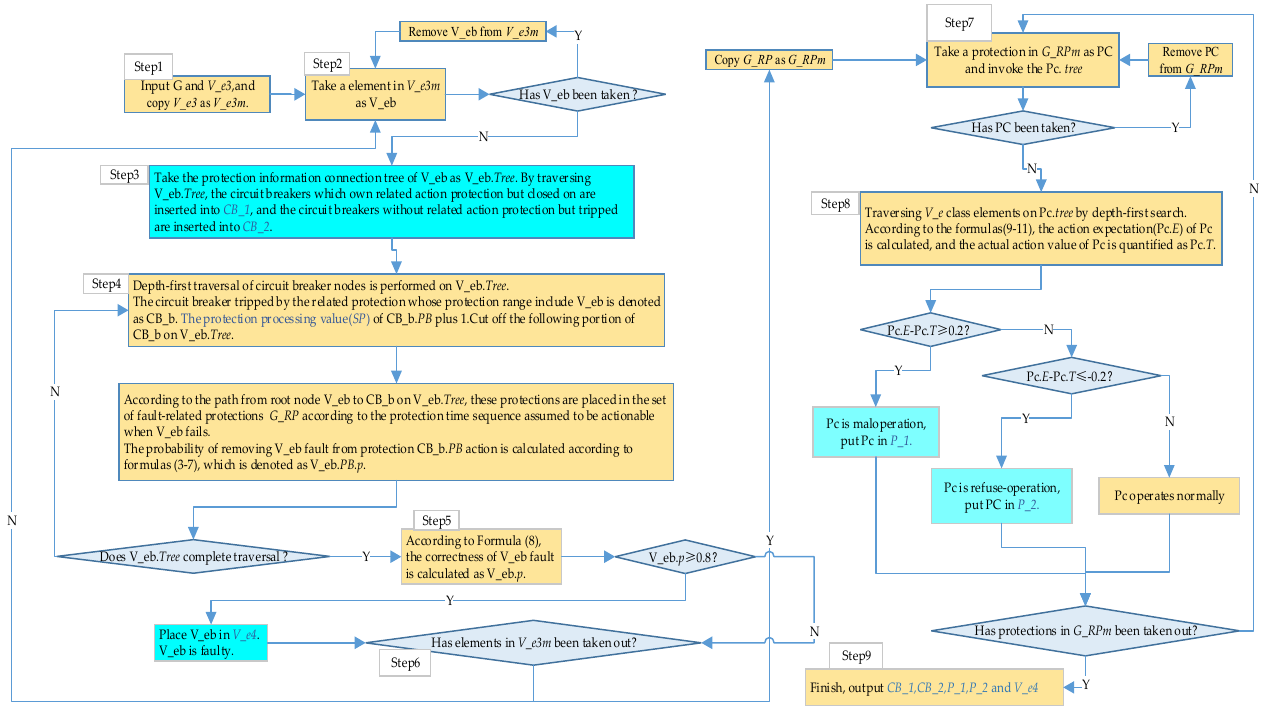
Figure 8. Algorithm 3 flow chart.